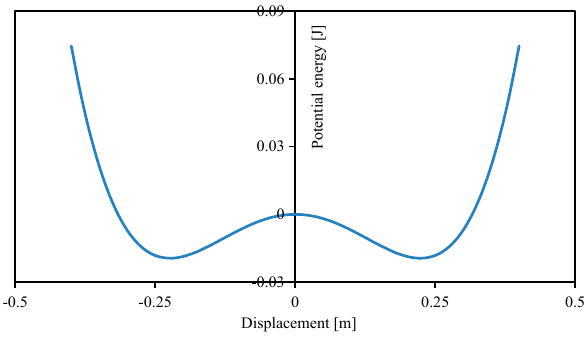
Figure 4. The potential energy distribution of bistable vibration model. In Figure 4, the abscissa is the transverse displacement of the mass block, and the ordinate is the potential energy, it is found from the figure that the potential energy dis- tribution has two-well characteristics (There is a valley of potential energy at each side of the graph, the valley bottom is the equilibrium position of the mass block at rest.). At the center of the graph, there is a mountain potential energy peak, which corresponds to the potential energy at which the mass block passes the vibration model’s central position. In general, the mass receiving relatively weak random excitation signal vibrates sin- gly on the left or right side, as shown in Figure 5a,b. In order to generate stochastic reso- nance, a periodic excitation signal is needed to be applied to the mass block to cross the central position and generate a bistable vibration state across both sides, as shown in Fig- ure 5c. Therefore, the amplification effect of this kind of stochastic resonance can play a role in vibration power generation, which is helpful to improve the efficiency of tradi- tional vibration power generation.